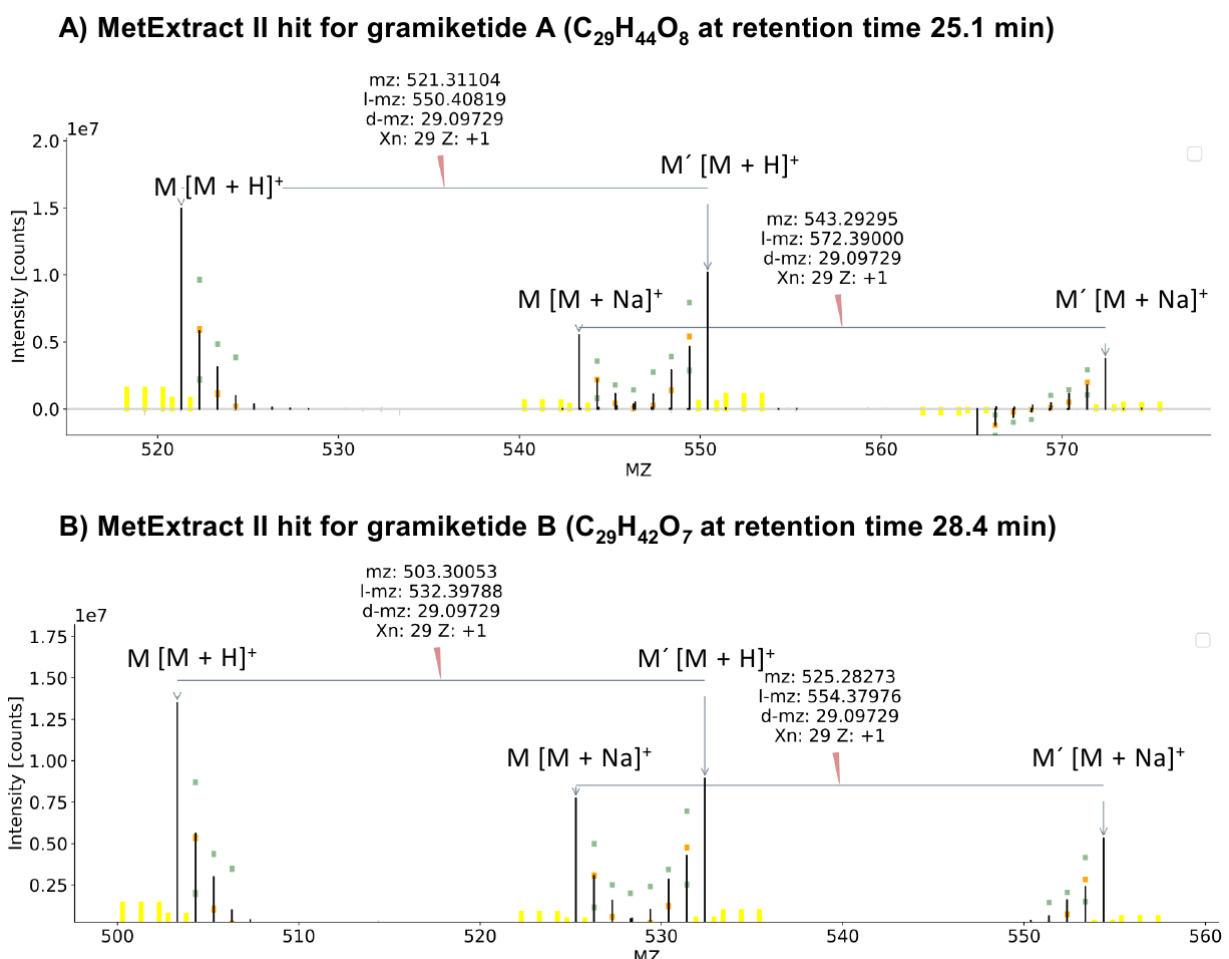
Figure 3. MS 1 spectra of metabolite ions, identified by MetExtract II in the native/uniformly 13 C labeled 1 + 1 mixed supernatant samples of strains #1290 and #1291 after cultivation in liquid minimal medium. ( A ) the spectrum for [M + H] + and [M + Na] + ions of C 29 H 44 O 8 and ( B ) the spectrum for [M + H] + and [M + Na] + ions of C 29 H 42 O 7 , confirming the number of carbon atoms contained to be 29 in both cases.